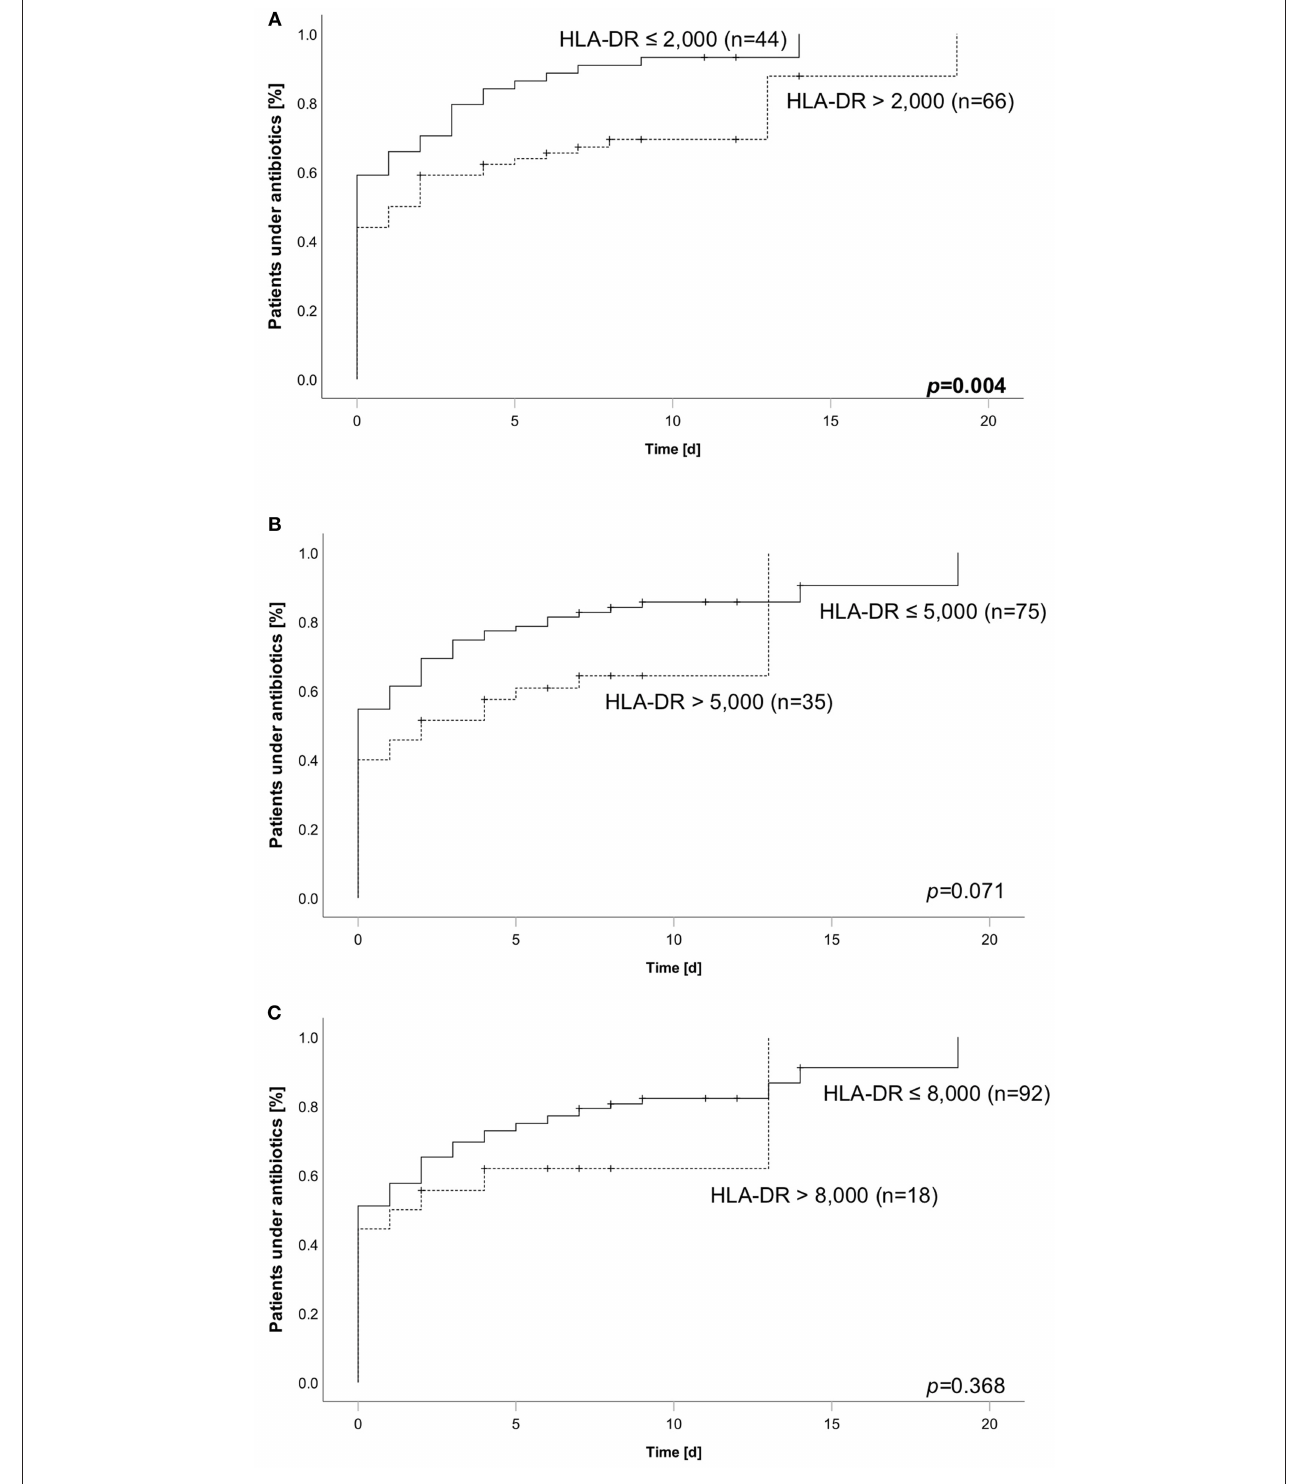
FIGURE 4 | Cumulative incidence of antibiotic therapy over 28 days stratified according to HLA-DR thresholds of (A) 2,000, (B) 5,000, or (C) 8,000. Dashed line always indicates subgroup above corresponding threshold, whereas solid line indicates the group of patients below. Number in brackets equal subgroup size, a total of 110 patients has been analyzed. Group comparison was performed using logrank test and calculated p -values are given within the subpanels. Bold type indicates a p ≤ 0.05, assumed as significant.